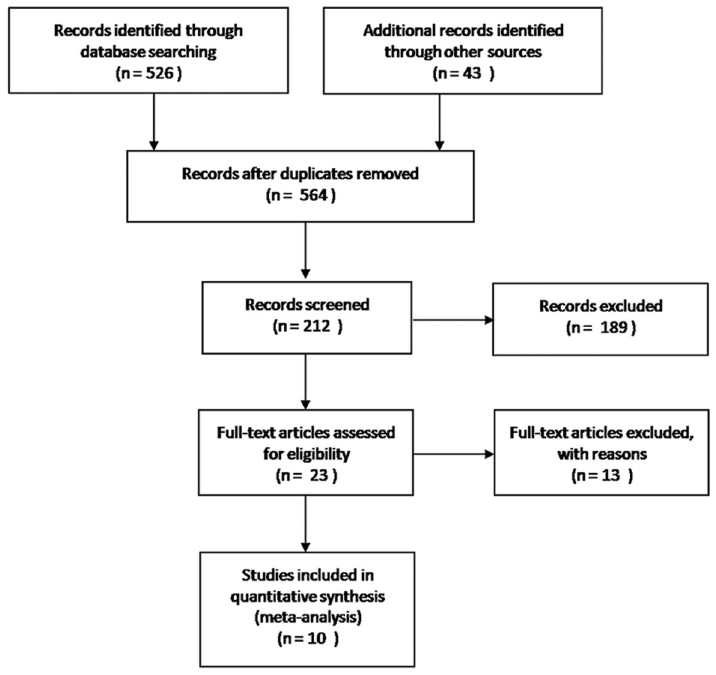
Figure 1. Identification of studies for inclusion in the